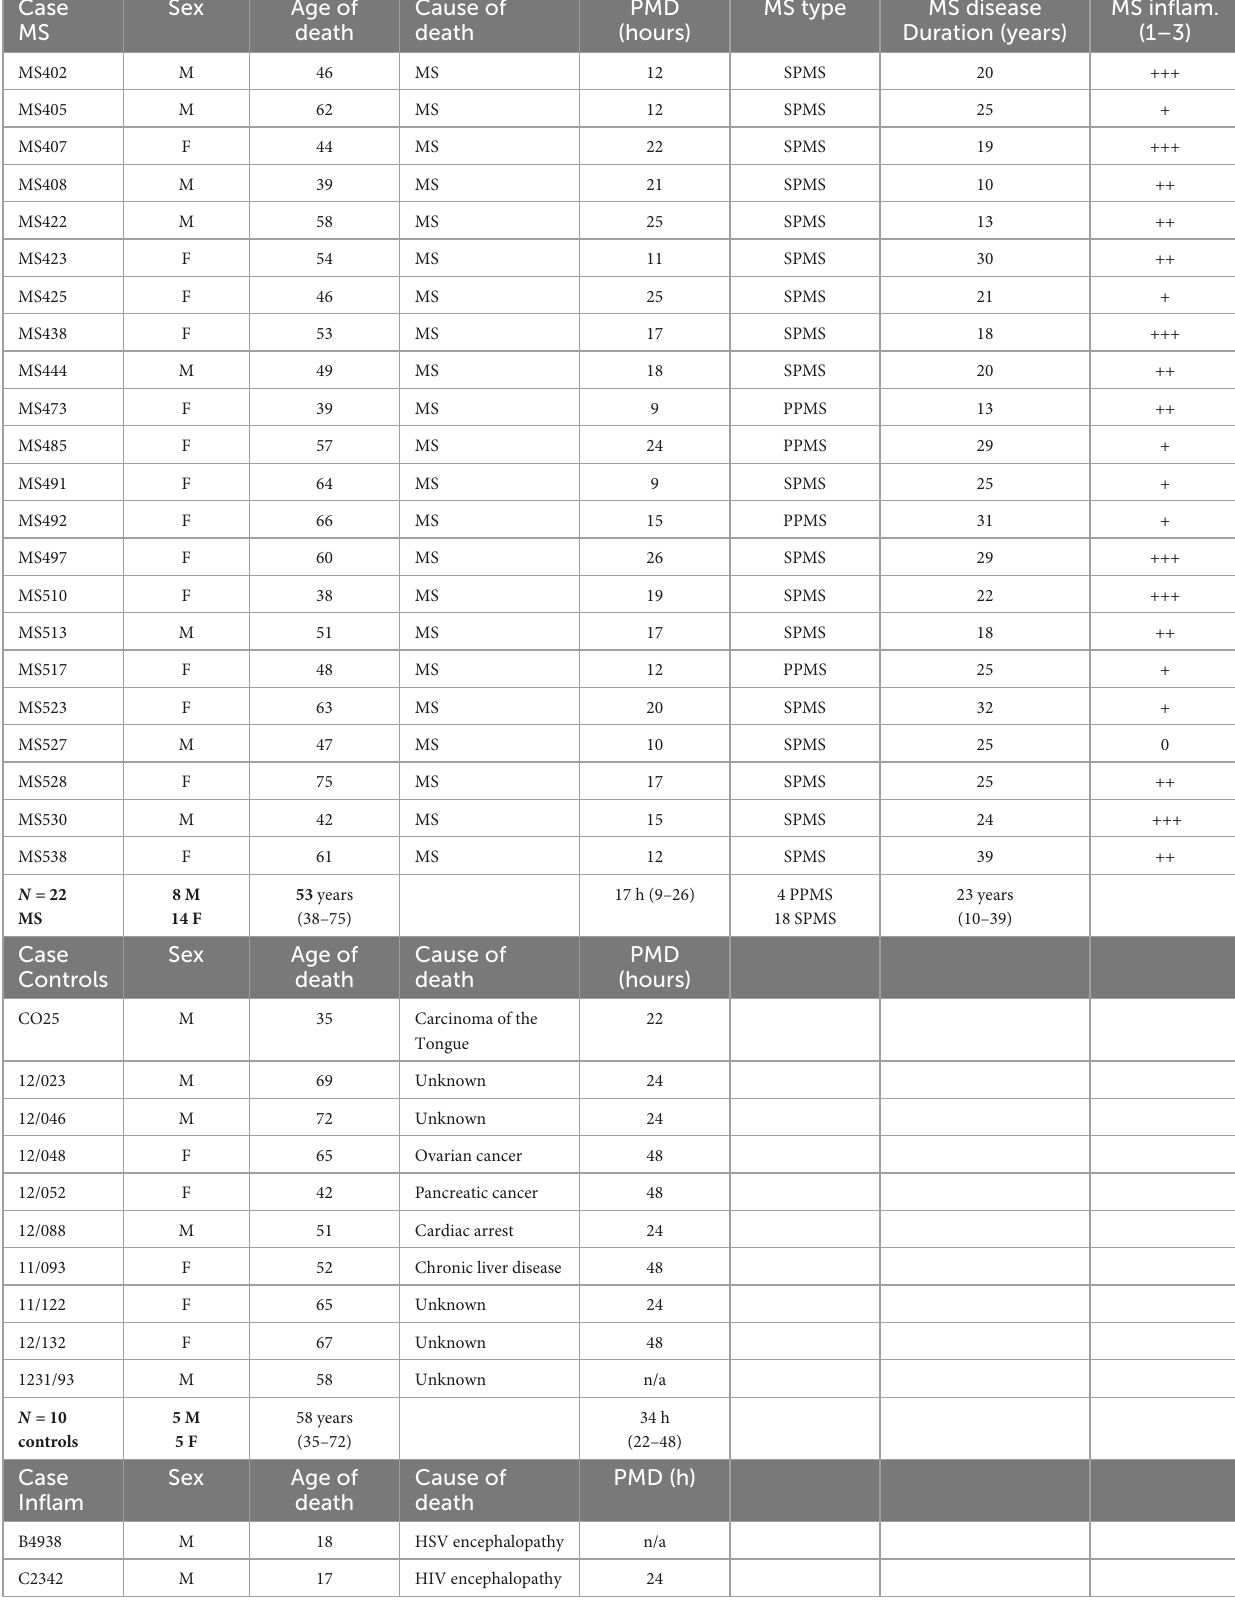
TABLE 1 Summary of MS, non-neurological disease controls, and inflammatory disease controls (Inflam) used in this study. Case